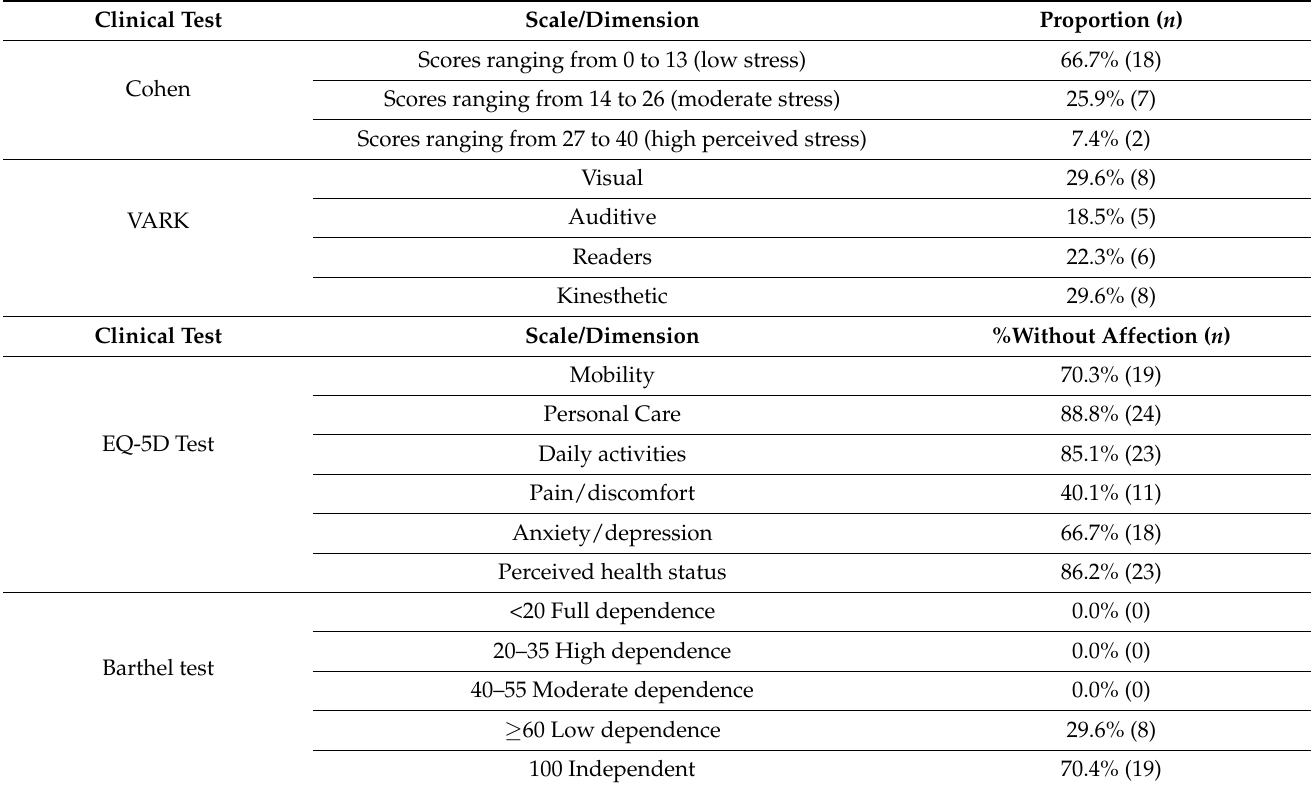
Table 2. Results from the clinical